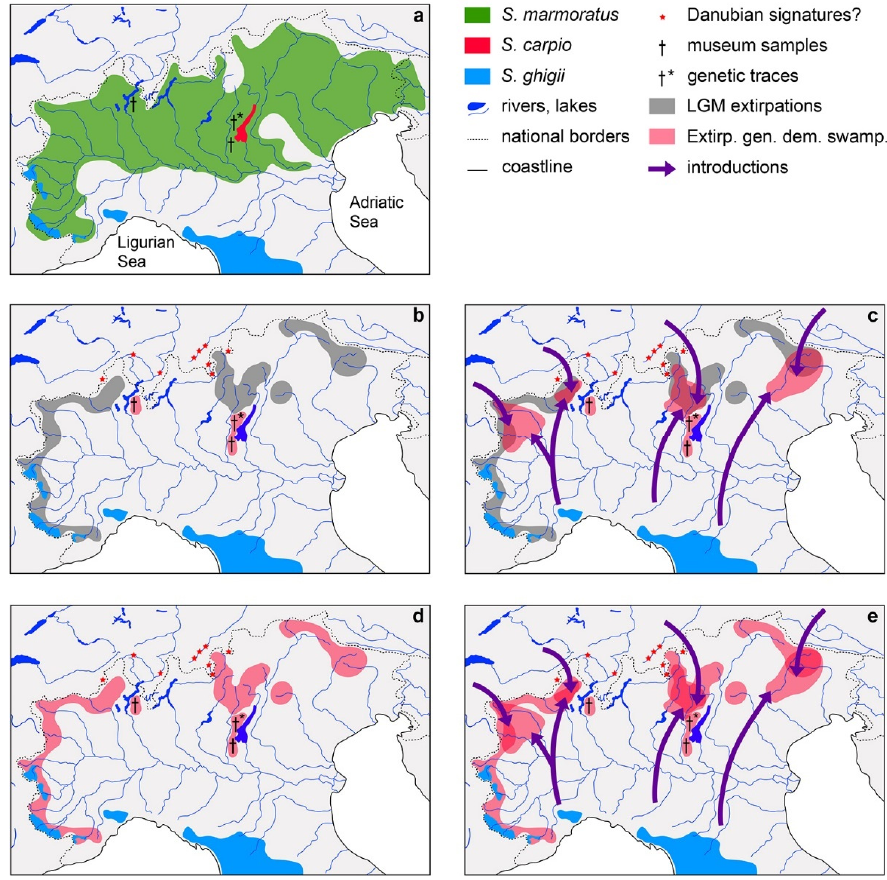
Figure 4. Present distribution of trouts in northern Italy and hypothetical reconstructions of the de- mographic history of S. ghigii in this geographic area; ( a ) present distribution of Alpine and subal- pine trouts in northern Italy, modified from [23,48,90,121]; ( b ) graphical representation of the hypo- thetical distribution of S. ghigii that were extirpated during the LGM except in glacial refugia, lack of subsequent introductions of S. ghigii in historical times, and subsequent extirpations of relict na- tive populations in glacial refugia (e.g., Lake Maggiore, Lake Garda, except the South-western Alps), due to genetic or demographic swamping caused by the massive introductions of S. trutta during the last ~150 years; ( c ) as in ( b ), but with man-made introductions of S. ghigii from areas outside its original distribution; ( d ) hypothetical distribution of S. ghigii populations that survived the LGM, lack of subsequent introductions of S. ghigii in historical times, and subsequent extirpations of relict native populations in glacial refugia, except the South-western Alps, due to genetic or demographic swamping caused by the massive introductions of S. trutta ; ( e ) as in ( d ), but with man-made intro- ductions of S. ghigii from areas outside its original distribution. In legend, present distribution of the three trout species: S. marmoratus (green area), S. carpio (red area), and S. ghigii (blue area); Dan- ubian signatures?= records of genetic variants possibly introduced from the Danube basin [100,102,103]; museum samples= records of ADcs-1 in two 19th-century museum samples [83]; ge- netic traces= potential traces of extirpated S. ghigii populations [92]; LGM extirpations= hypothetical distribution (grey area) of S. ghigii populations that were extirpated during LGM; Extirp. gen. dem swamp.= hypothetical distribution (pink area) of S. ghigii populations that were extirpated by de- mographic or genetic swamping caused by introductions of S. trutta in historical times; introduc- tions= directions ( purple arrows) of S. ghigii man-made introductions from areas outside its original distribution.